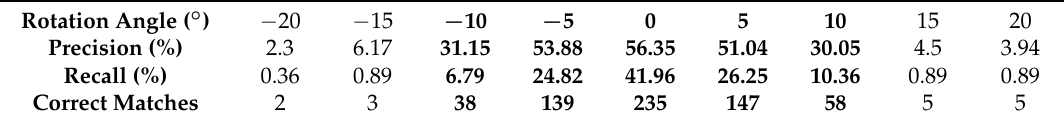
Table 8. The precision, recall, and correct matches of different rotation angles (degree).